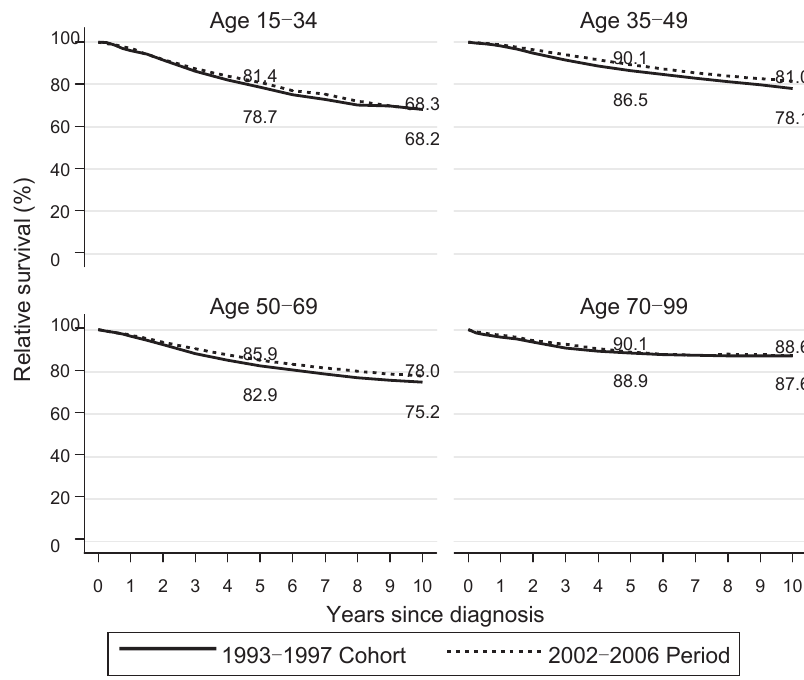
Figure 3. Relative survival of patients with breast cancer by age